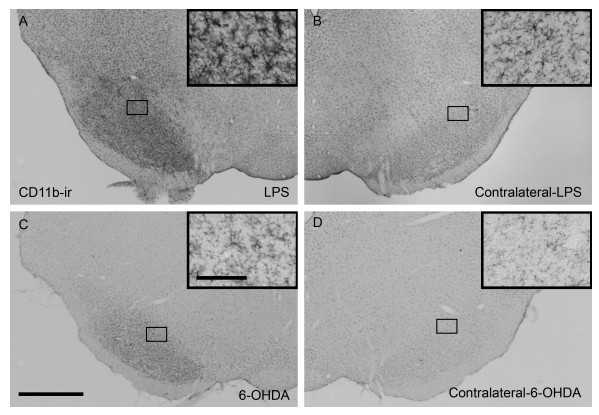
Representative coronal sections of microglia in the ventral midbrain at the level of the substantia nigra (SN) visualized by CD11b-immunoreactivity (-ir). (A) activated microglia in the SN of a rat injected in the SN with LPS 12 days prior and (B) the contralateral side. (C) low level of microglia activation 12 days following an intra-striatal injection of 6-OHDA (5.0 μg) and (D) the contralateral side showing resting microglia. Insets are 20× images taken from the area outlined in lower magnification pictures. Scale bar of inset, 100 μm; scale bar of low magnification images (2.5×), 1.0 mm).